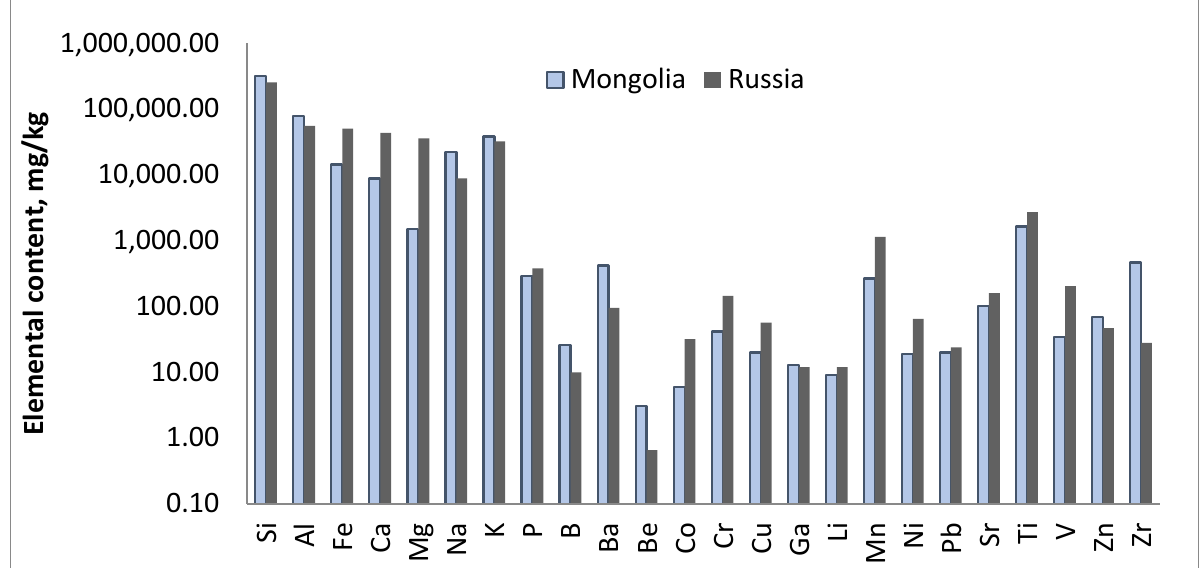
Figure 1. Elemental profiles of the soils. The element ratio in the roots and soil indicates the intake of individual elements by the root system. The value of the ratio depends both on the specific physiological characteristics of the plant and the total element content in the soil. The two plants of the Thymus species growing in different climatic conditions demonstrate unrestricted uptake of only such elements as P, B, Cu and Zn. A similar phenomenon was observed in the drier climate of Mongolia for both the essential elements (i.e., Ca, Co, Mg, Mn and V) and conditionally toxic elements, such as Ni and Sr, the concentrations in the soil of which were very low. Around Lake Baikal, the contents of Mg, Mn, Ni, V and Sr in the soil are higher, and the root system limits their uptake into the plant. Only the accumulation of Ba, which is scarce in the soil, is unrestricted by the root system. In the Mongolian soil samples, the contents of Ca, Mg, Fe, Mn, Co, Cr, Ni and Ti were lower compared with the Baikal samples. Despite this, the distribution profiles of these elements in plant organs differed slightly. The Si, Al, Be, Ga, Li, Na, Pb and Zr concentrations were found to be high in the Mongolian soil, but their uptake through the roots was limited (Figure 2), and they hardly accumulated at all in plant tissues. Though the total contents of Si, Na and Be in the Baikal soil were lower, the distribution profiles of these elements in the soils and organs of the two plants were similar to each other: the concentration of the element in the roots decreased sharply, remained approximately the same in the stems, leaves and flowers or increased slightly in the leaves and flowers (Figure